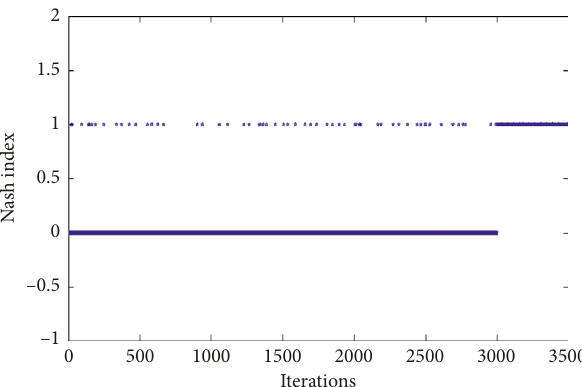
Figure 5: Adjusting process of Nash indices during 3500 iterations in our proposed GDCAC-based approach.